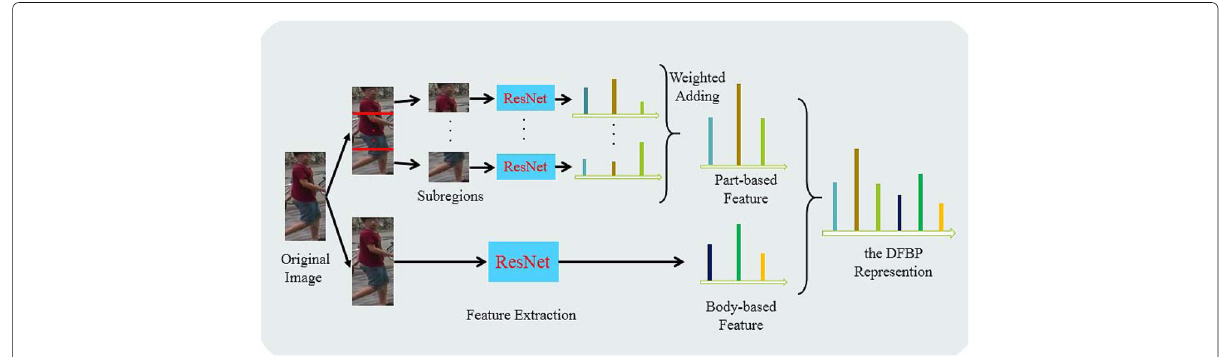
Fig. 4 The flowchart of the proposed DFBP extraction